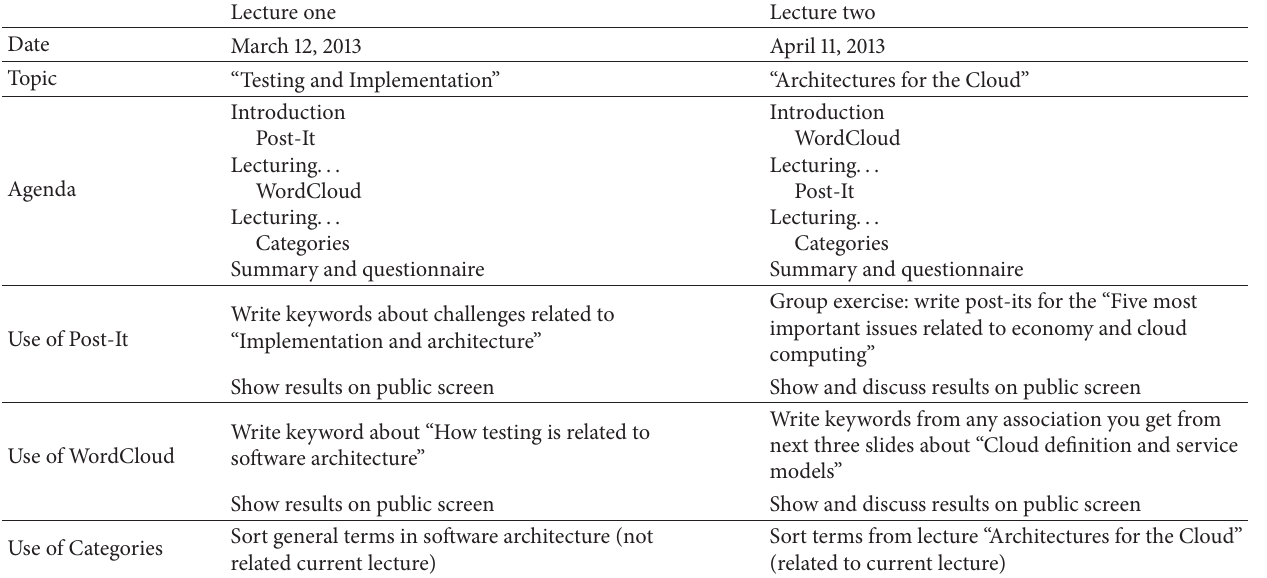
Table 2: Summary of quasiexperiment